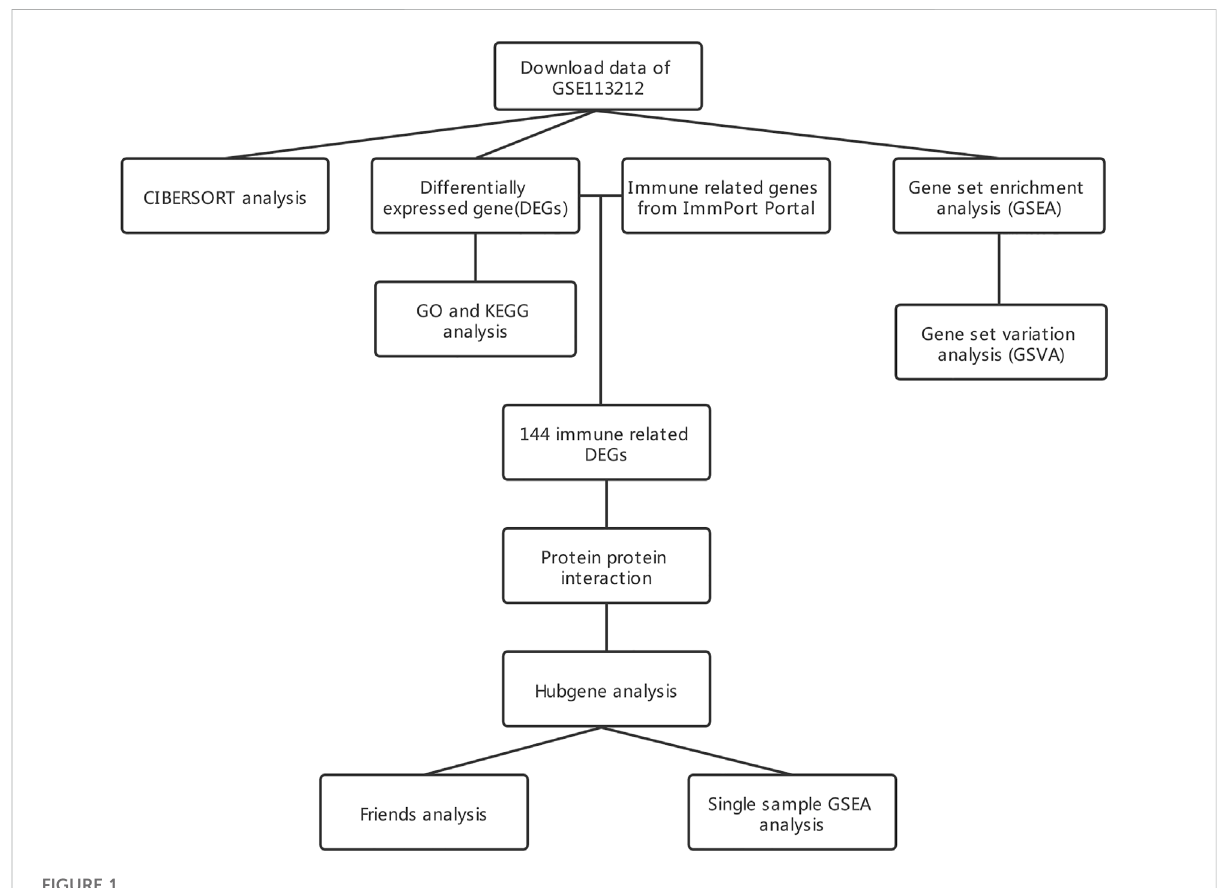
FIGURE 1 Flowchart of the study